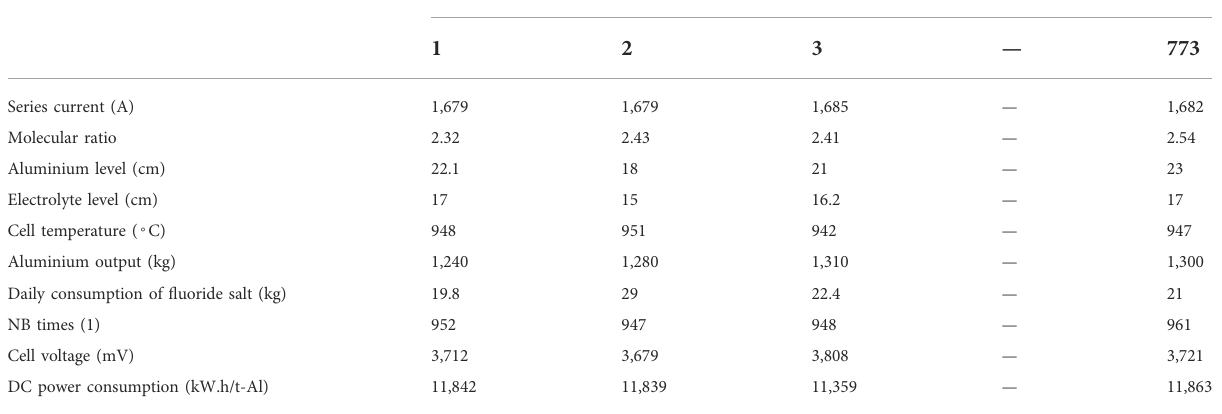
TABLE 6 Data samples of aluminium electrolytic